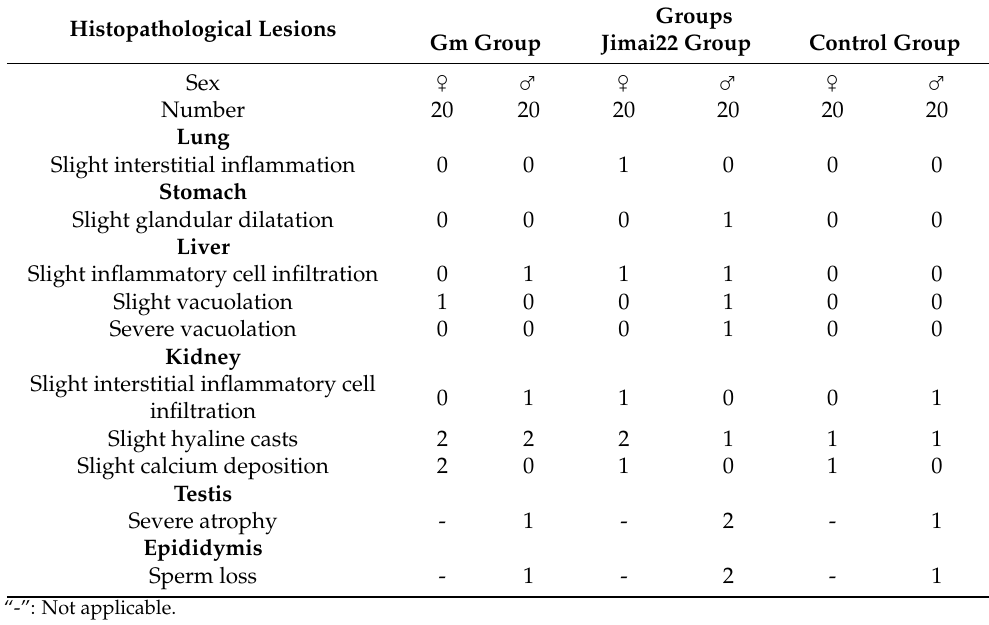
Table 5. Histopathological results of three groups at week 13.